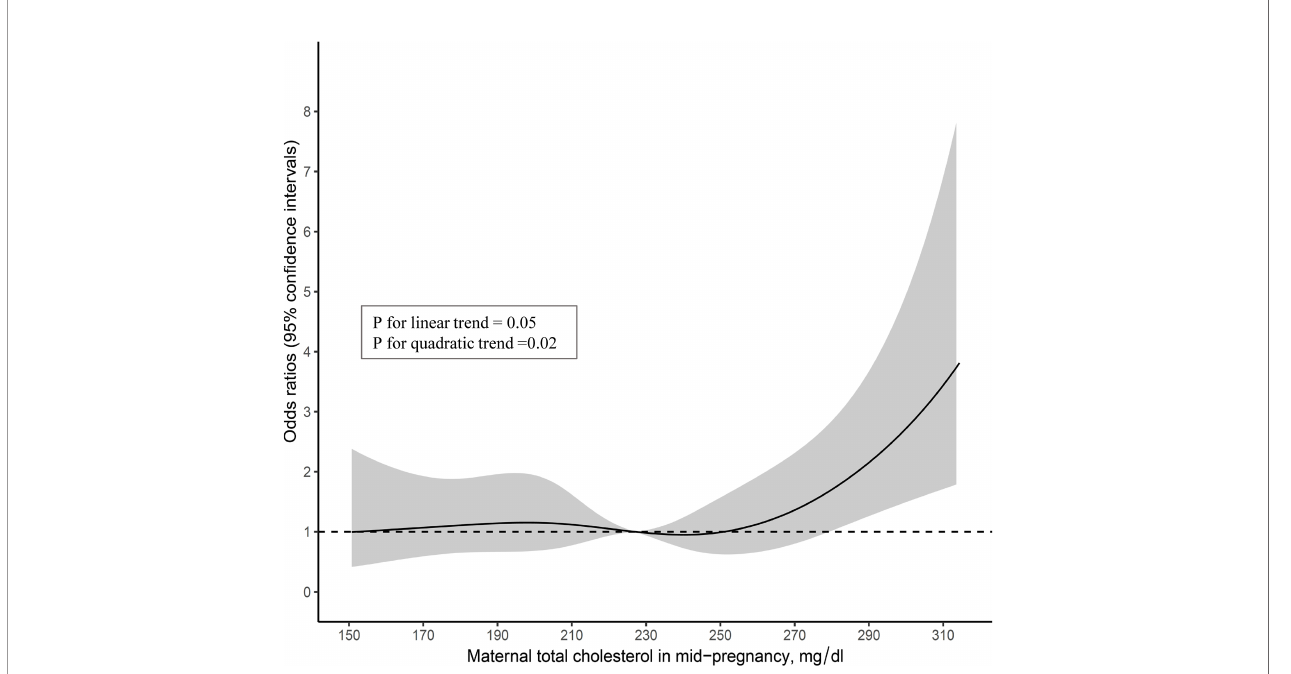
FIGURE 2 | Multivariable-adjusted associations of maternal total cholesterol in mid-pregnancy with no-catch up growth in height at 3 years among infants born small-for-gestational-age at term